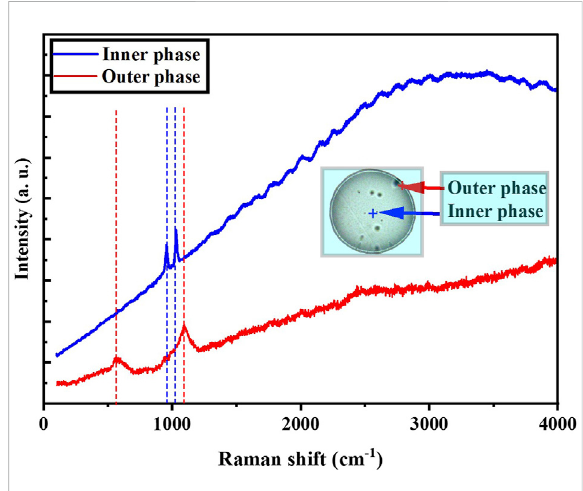
FIGURE 3 Raman spectra of liquid-liquid phase-separated PM 2.5 particle collected in 28 December 2020 at relative humidity of 80%. Blue dash lines represent the inorganic peaks while the red dash lines represent the organic